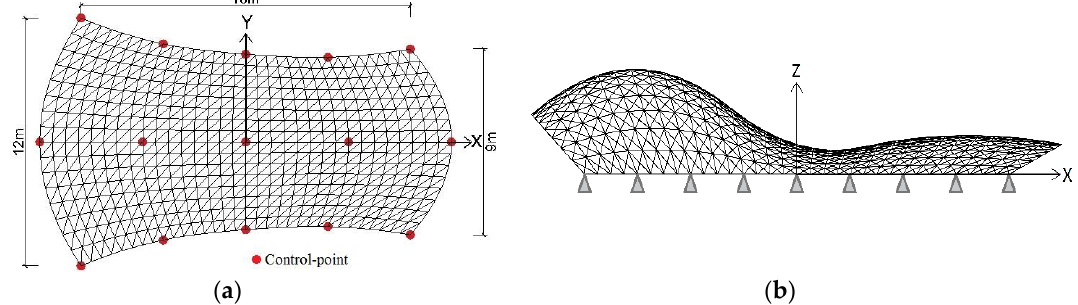
Figure 11. Layout of control points, mesh and the initial geometry of Model 2: ( a ) Layout of control points and mesh; and, ( b ) Initial guess shape.